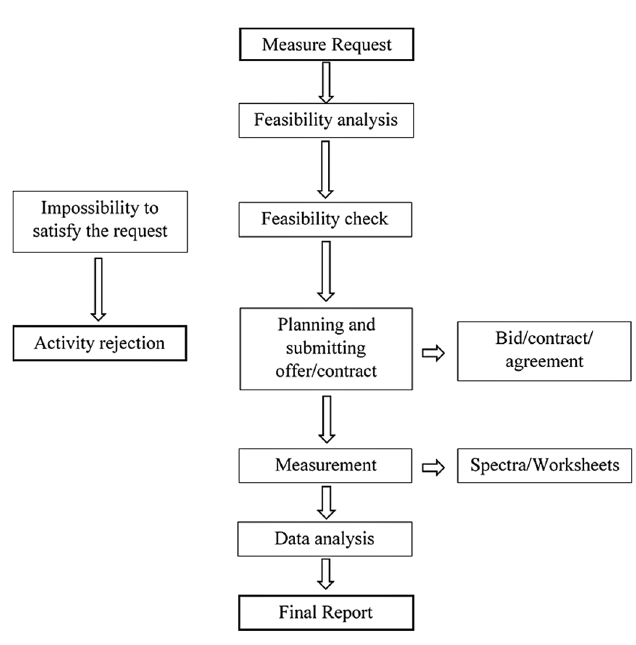
Fig. 2. Internal organization of LaRa in according to ISO